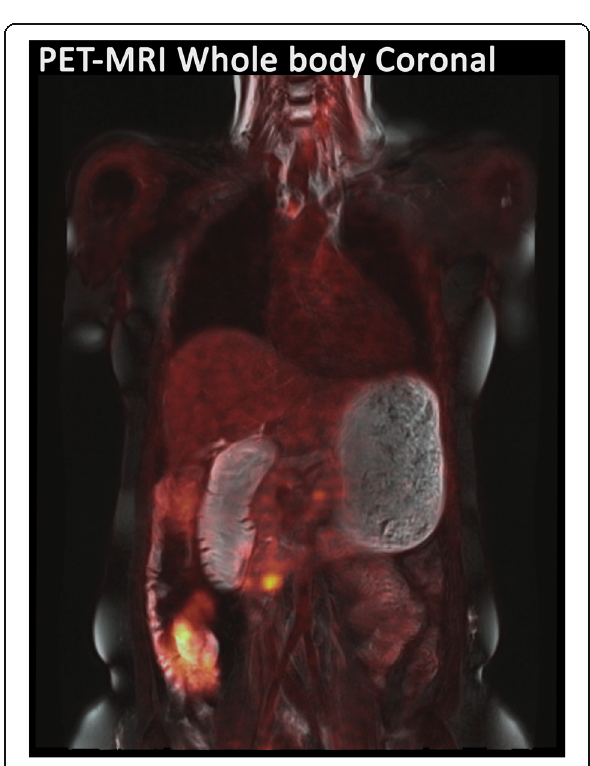
Fig. 2 Whole-body PET-MRI fusion showing para-aortic lymph node